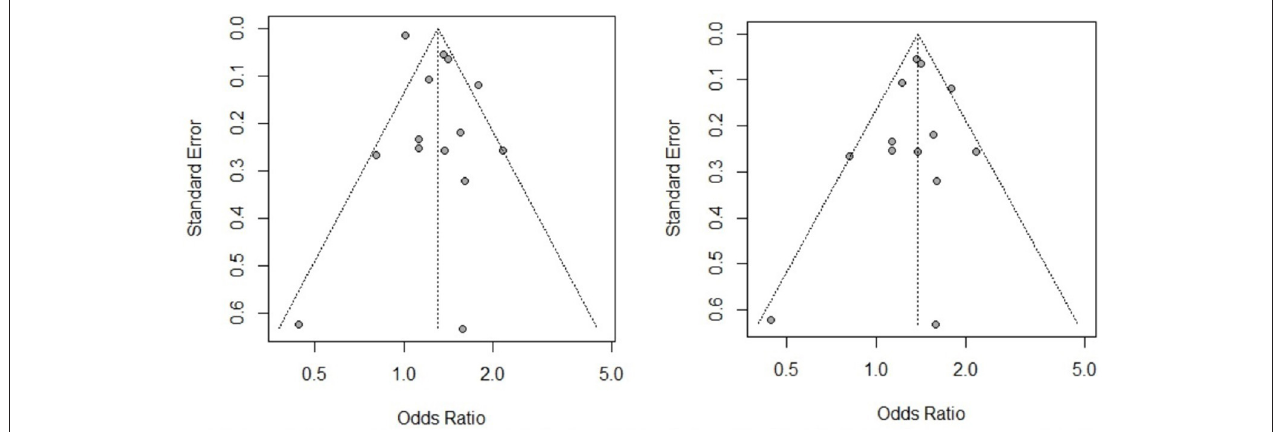
FIGURE 6 | Funnel chart of CE risk factor sex before and after study design subgroup analysis.